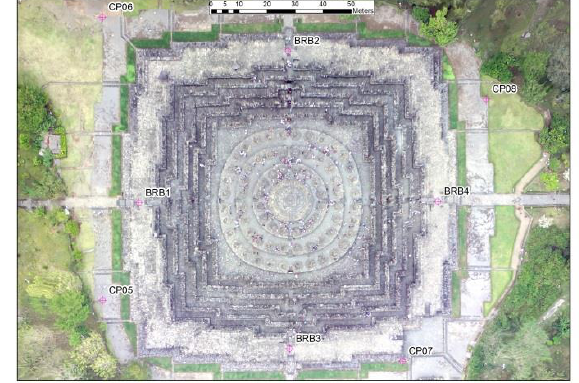
Figure 11. GCPs from GPS Survey